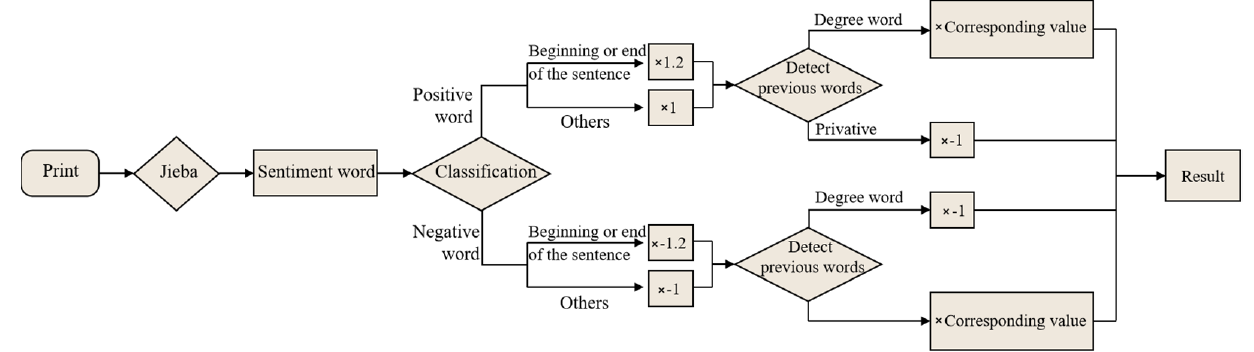
10 of 31 Figure 6. Schematic of grading result. 3.2. Sentiment Analysis Based on Sentiment Dictionaries Identifying public attitudes and opinions on the lakefront landscape plays an im- portant role in planning the future development of Wuhan’s lakefront area. In this study, the textual content of microblogs was used to analyze the sentiments of microblog users. Text sentiment analysis is a tool for extracting subjective information from natural lan- guage texts [90]. It also aims to classify texts into sentiment categories, such as positive or negative, or more fine-grained categories, such as very positive, positive, and neutral [91]. Sentiment methods based on sentiment dictionaries and sentiment analysis based on ma- chine learning are the two most common approaches in text sentiment analysis [92]. The content of microblog texts is mostly concise, with 20–30 words mostly and at most 140 words. It is also difficult to analyze based on deep context. Thus, sentiment analysis meth- ods based on sentiment dictionaries were used in this study to collect public opinions and sentimental responses to urban lakefront spaces [93,94]. HowNet Chinese Sentiment Dictionary is a general knowledge base that describes the concepts represented by Chinese and English words; this general knowledge base also reveals the attributes of concepts and the relationships between concepts as the basic con- tent [95], including positive sentiment words, negative sentiment words, deactivation words, and degree adverbs. In this study, the sentiment words in the Tsinghua University dictionary and NTUSD dictionary of Taiwan University were expanded on the basis of HowNet dictionary to improve the accuracy of text sentiment analysis [96]. According to the technical route shown in Figure 7, the microblog data of the lake- front area were scored following the steps of vocabulary-sentence-microblog after text segmentation. It is noteworthy that sentiment words at the beginning or end of a sentence often determine the overall color of a sentence in Chinese expression, so the weight of these emotion words is expanded to ±1.2. Moreover, degree adverbs before the sentiment